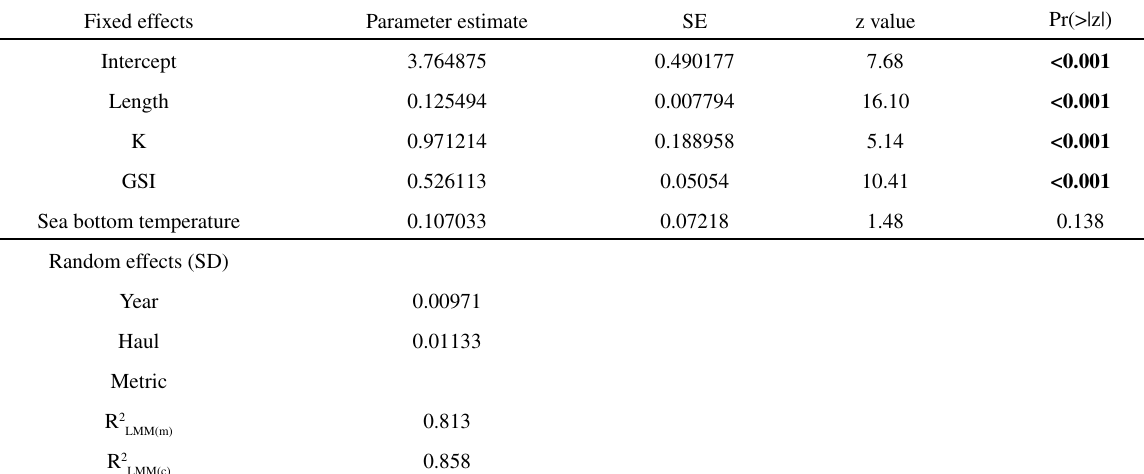
Table 3. – Parameters of the optimal GLMM using potential fecundity as the response variable and including length, condition factor (K), gonadosomatic index (GSI) and bottom temperature from 21 years (N=280 observations) as explanatory variables. SD, standard deviation; SE, standard error. R2LMM(m) describes the proportion of variance explained by fixed effects alone and R2LMM(c) describes the proportion of variance explained by fixed and random effects